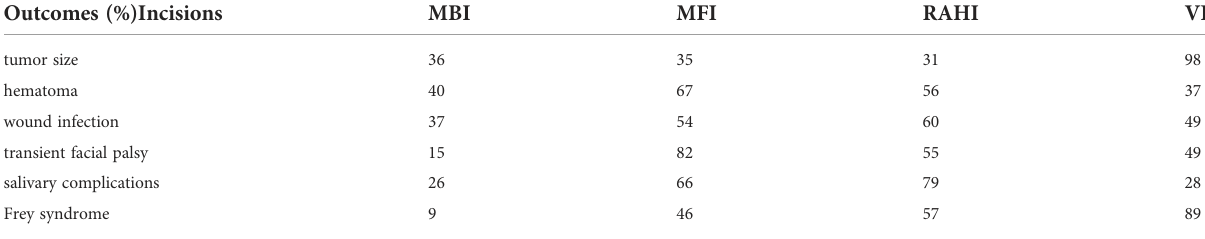
TABLE 6 SUCRA of secondary outcomes.